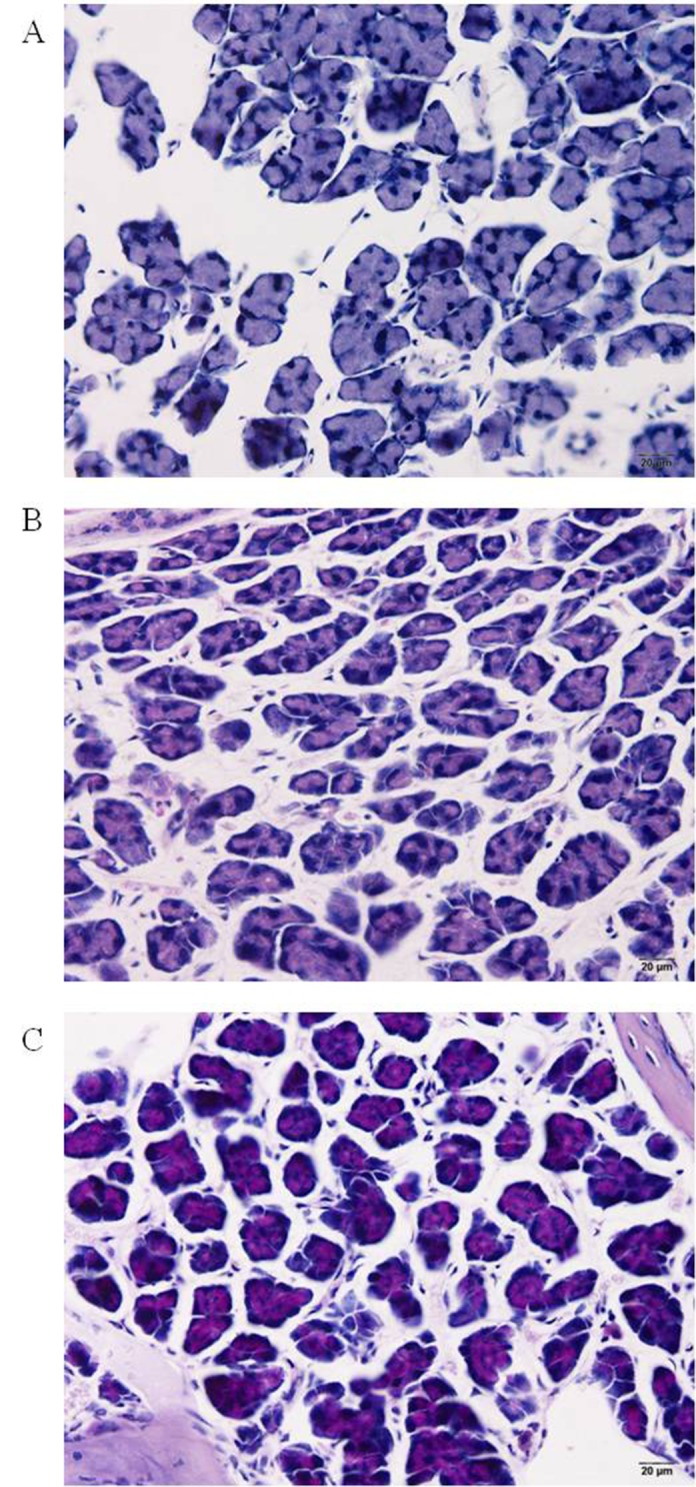
(A-C) Grades 1–3 of color intensity of the PAS-stained mucus glands in nasal tissues of mice (original magnification 400×).The color (magenta) is a result of the reaction between PAS dye and glycogens in the mucus.